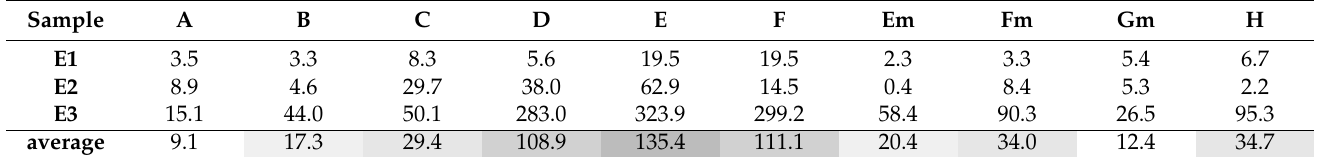
Table 4. Fold increase in number of methanogenic archaea in all lysis variants compared to the non-mechanically-lysed controls.